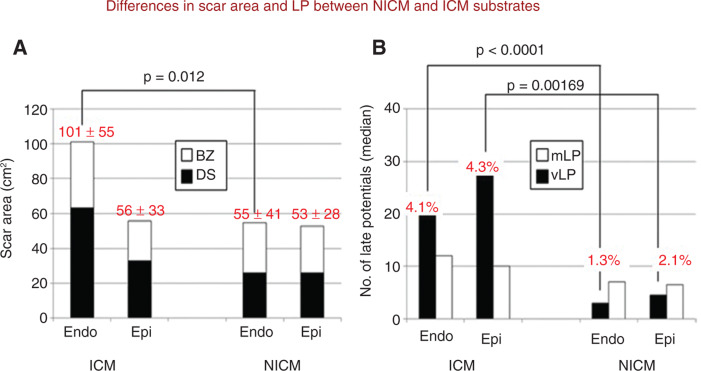
Differences in scar area and late potentials between ICM and NICM substrates. A: With high-density electroanatomical maps of patients with ICM, the dense scar was twice as large on the endocardium as compared with on the epicardium. Such predilection for endocardial scar was not as prominent in patients with NICM, with nearly equal extents of scar on the endocardium and epicardium present. Less dense scar (solid bars) was observed in patients with NICM. The open bars indicate the border zone. B: Patients with ICM had more late potentials and evidence of slow conduction than patients with NICM. This difference was driven by a greater number of very late potentials (vLPs) (solid bars) in ICM. BZ: border zone; DS: dense scar; ICM: ischemic cardiomyopathy; mLP: moderate late potentials; NICM: nonischemic cardiomyopathy. Modified from Nakahara S, Tung R, Ramirez RJ, et al. Characterization of the arrhythmogenic substrate in ischemic and non-ischemic cardiomyopathy. J Am Coll Cardiol. 2010;55(21):2355–2365. Used with permission.